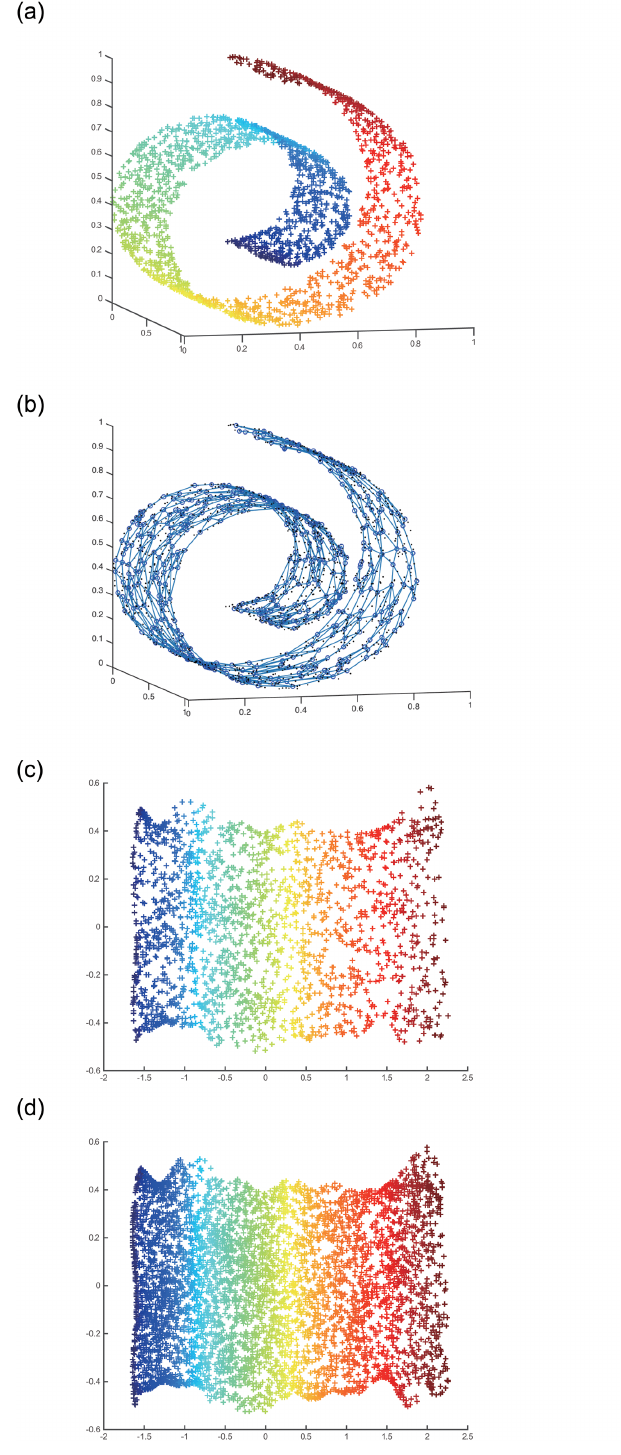
Fig 5. ITRN-ERBF results for Swiss roll. (a) shows Swiss roll dataset, (b) shows learing result by ITRN, (c) shows mapping of the training patterns, (d) shows mapping of the new dataset.